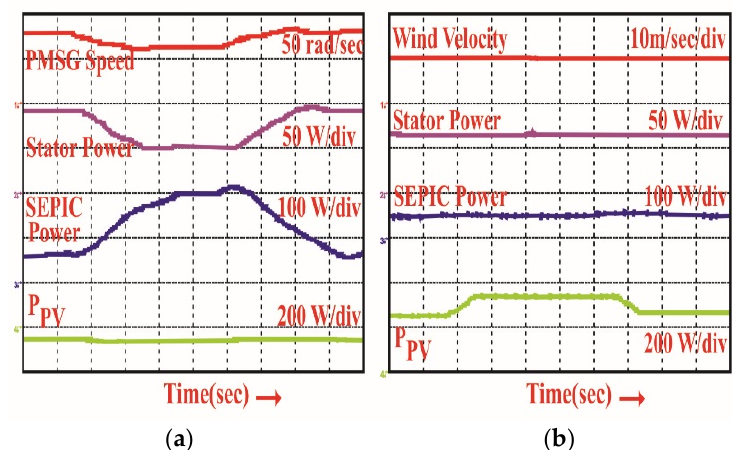
Figure 12. PV system responses under step ‐ changes in solar irradiation. Energies 2018 , 11 , x